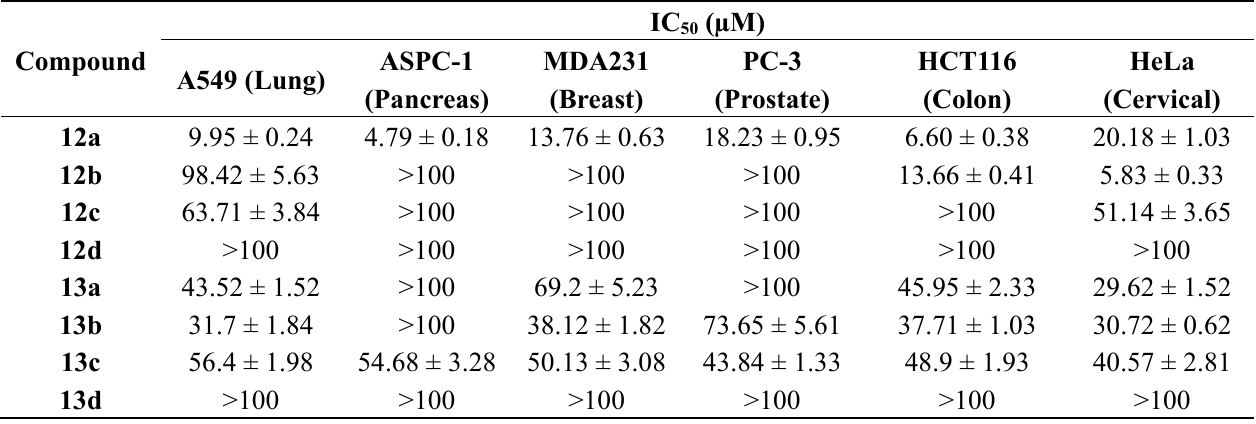
Table 1. Cytotoxic activities of isosteviol derivatives against six human attached cancer cell lines a .